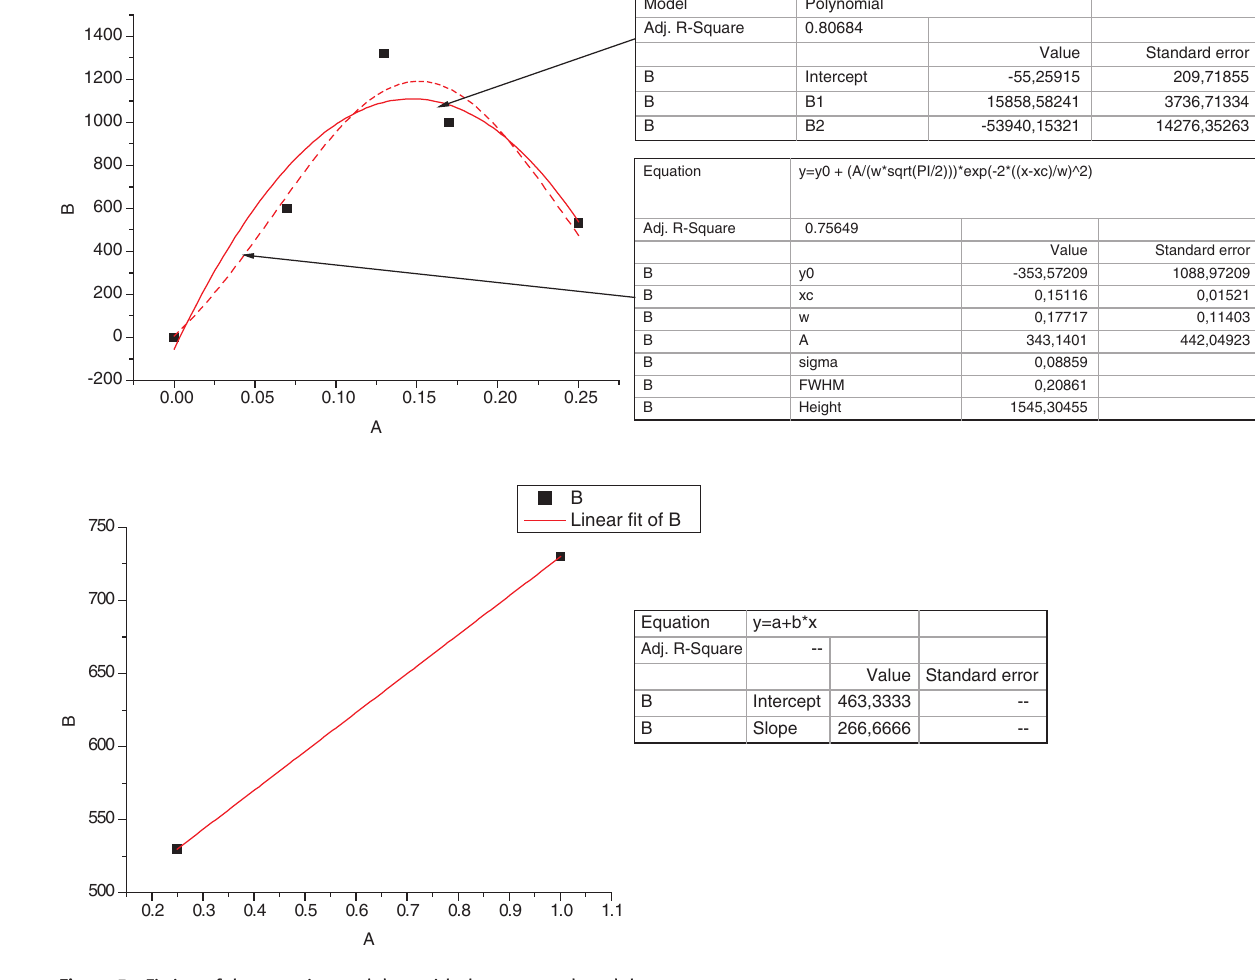
Figure 5: Fitting of the experimental data with the proposed model.